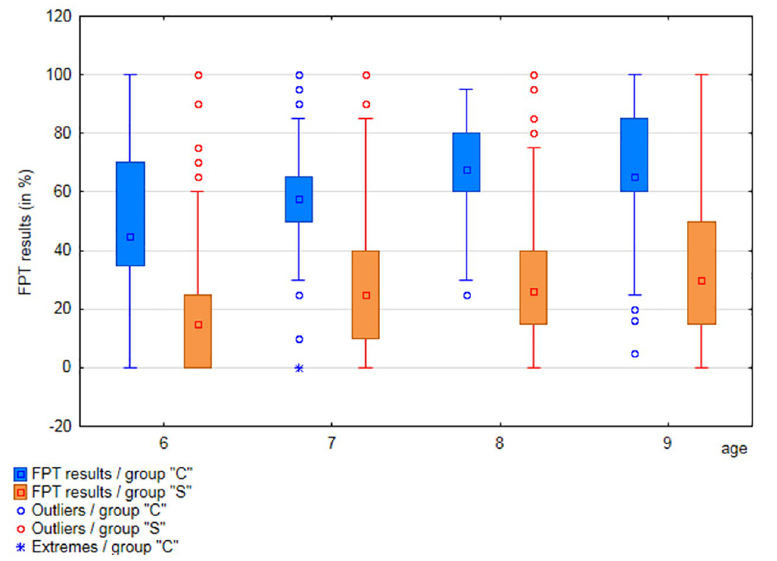
Fig 2. Comparison of the FPT test results, among age groups, in groups”C”